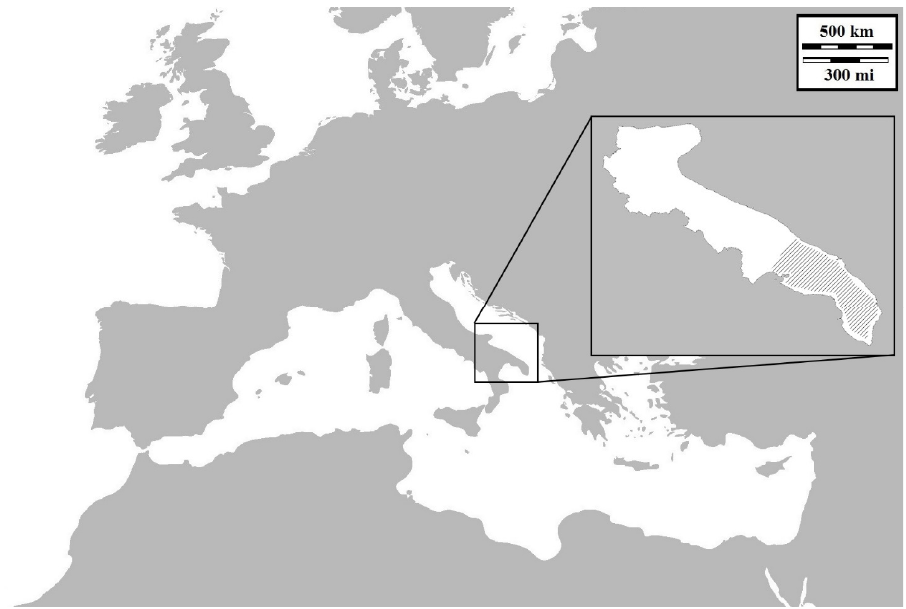
Figure 1. Mediterranean Sea: the Apulia (in the black box) and the Salento peninsula (highlighted with the striped pattern).